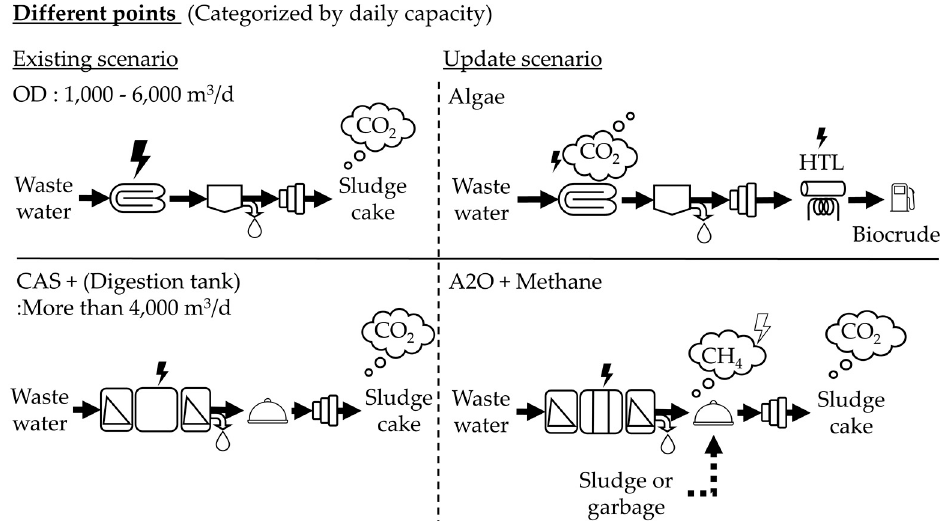
Figure 2. Existing and updated scenario classified by WWTP treatment process with daily treatment